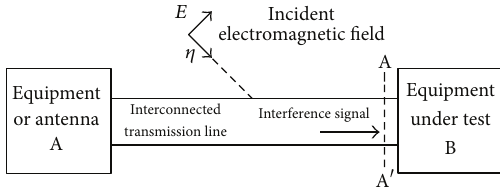
Figure 1: The structure of a typical interconnected system.